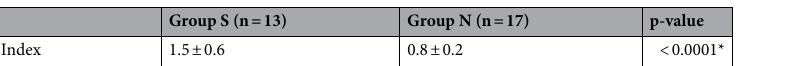
Table 4. DA index after birth compared between groups. DA index distal aortic arch index. * p < 0.05 between group S and group N.